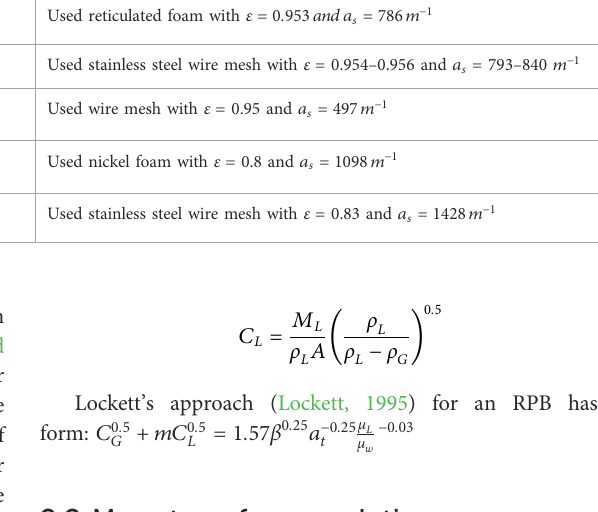
TABLE 2 Liquid holdup correlations for RPB. Reference Correlation for ε l Material